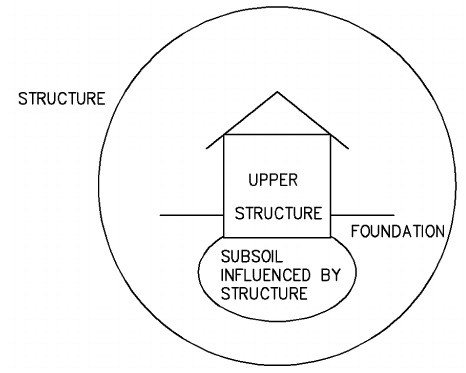
Figure 1. Interaction of structure and